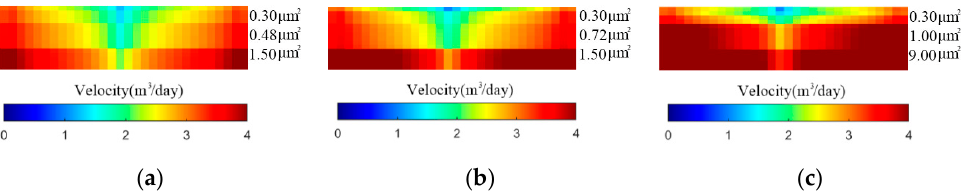
Figure 7. Fluid velocity profiles in the basic model with different permeability contrasts. ( a ) PC = 5; ( b ) PC = 15; ( c ) PC = 30.